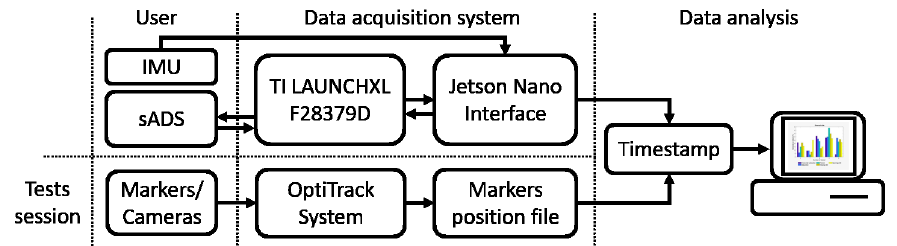
Figure 4. Flow diagram of the data acquisition system. On the left side, the movements of the user, the generated angles and the poses of the markers are shown; in the centre, the acquisition of data and communication between boards as well as the storage of positions of the reflective pointers; on the right side, the data analysis based on the timestamp of each